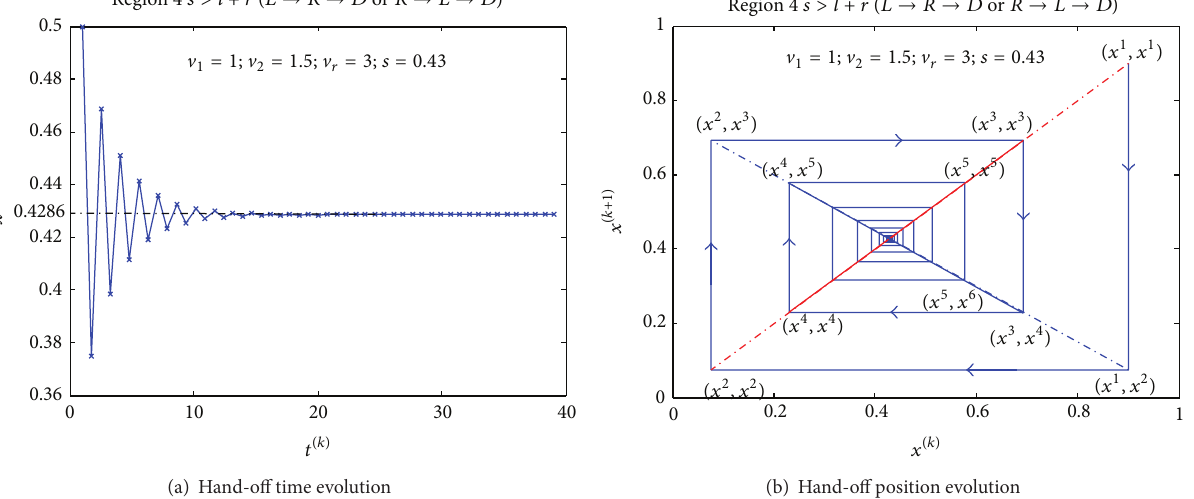
Figure 6: Convergence process in Region